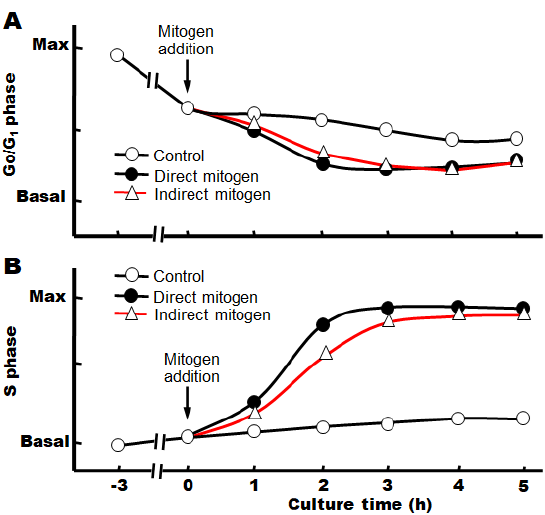
Figure 2. Cell cycle progression stimulated by mitogens in primary cultures. ( A ) Percent of total hepatocyte nuclei in the G 0 /G 1 phase of the cell cycle. ( B ) Percent of total nuclei in the S phase of the cell cycle.